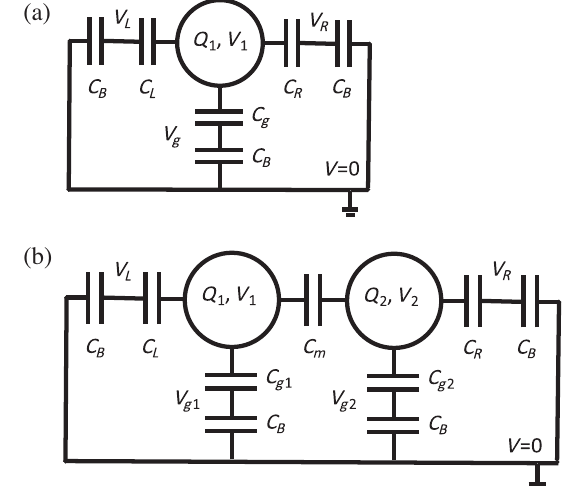
FIG. 11. Network of capacitances representing the (a) single- and (b) double-dot circuits. The capacitances C model the voltage